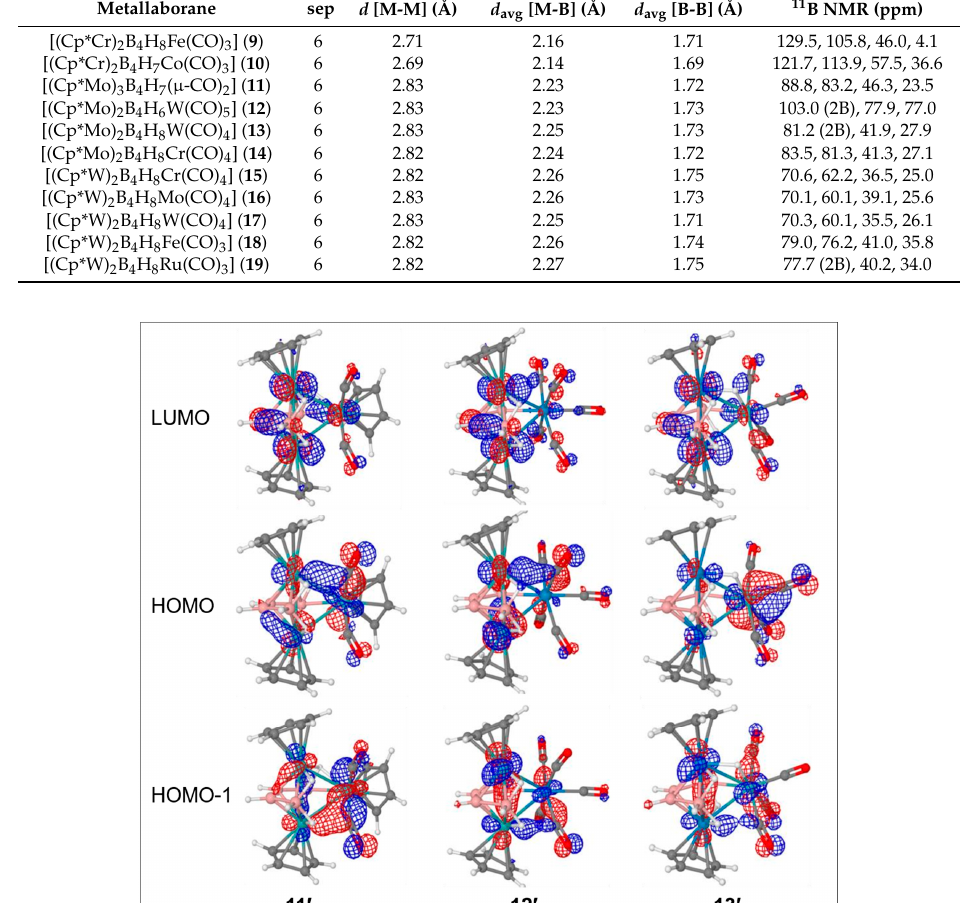
Figure 4. HOMO, HOMO-1 and LUMO plots of 11’ , 12’ , and 13’ . Reprinted and adapted with permission from Ref. [72]. Copyright (2019) American Chemical Society.